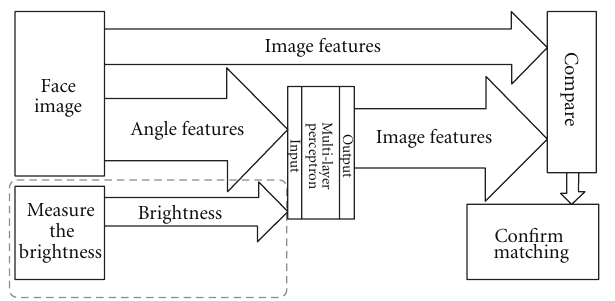
Figure 6: Block diagram of System I.